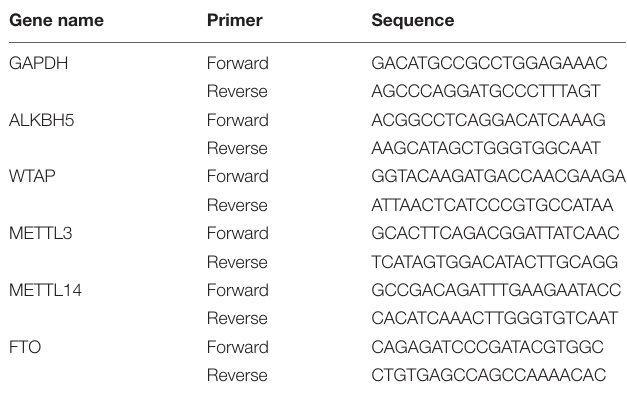
TABLE 1 | Primers used for qRT-PCR